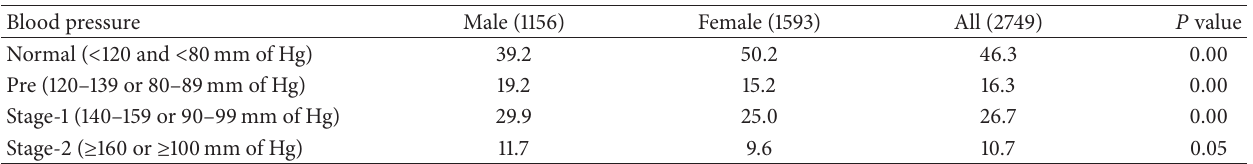
Table 4: Gender distribution of hypertension of rural cohort for assessment of cardiovascular diseases (CVDs) risk factors in sub-Himalayan region of India, 2011.